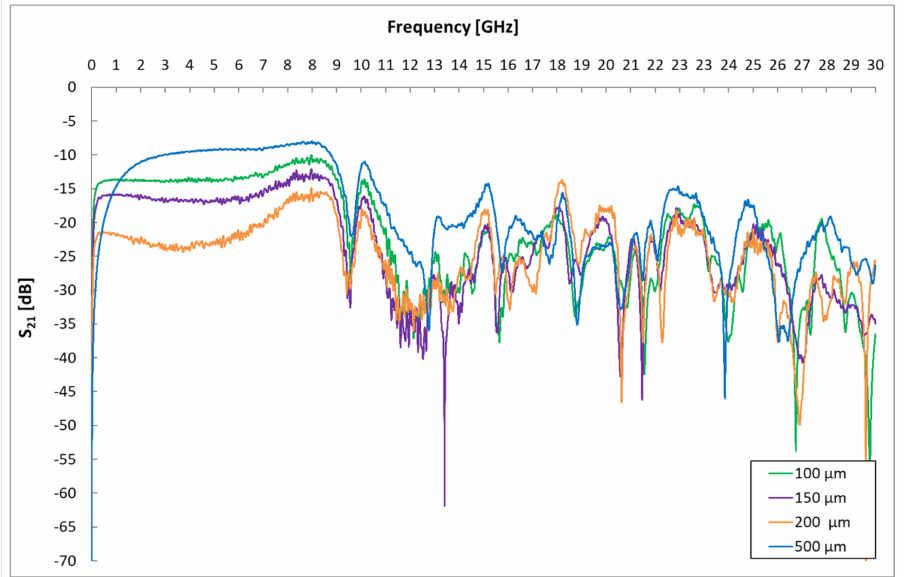
Figure 6. Influence of IDE gap on S 21 parameters.